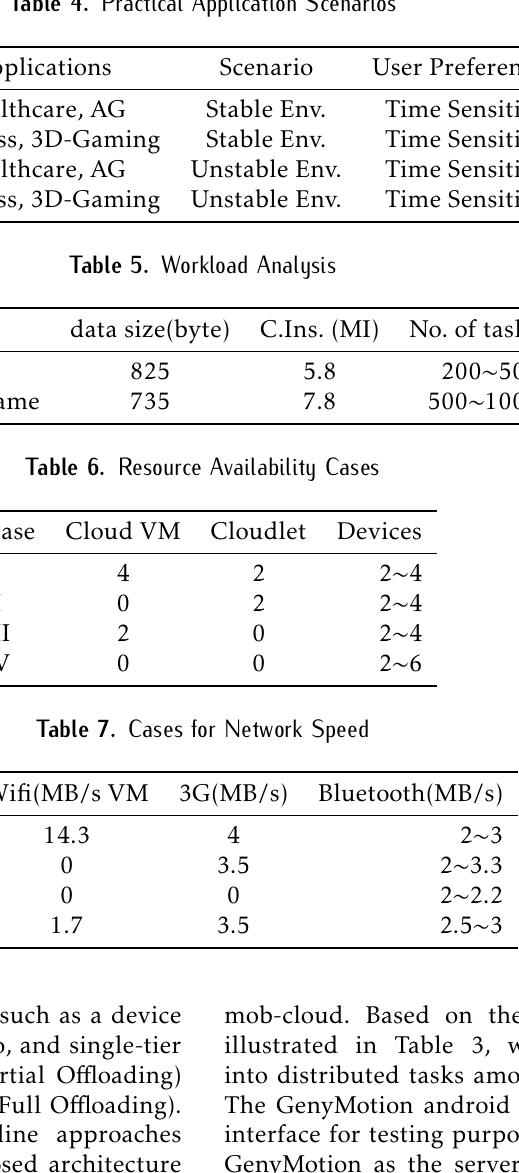
Table 4. Practical Application Scenarios